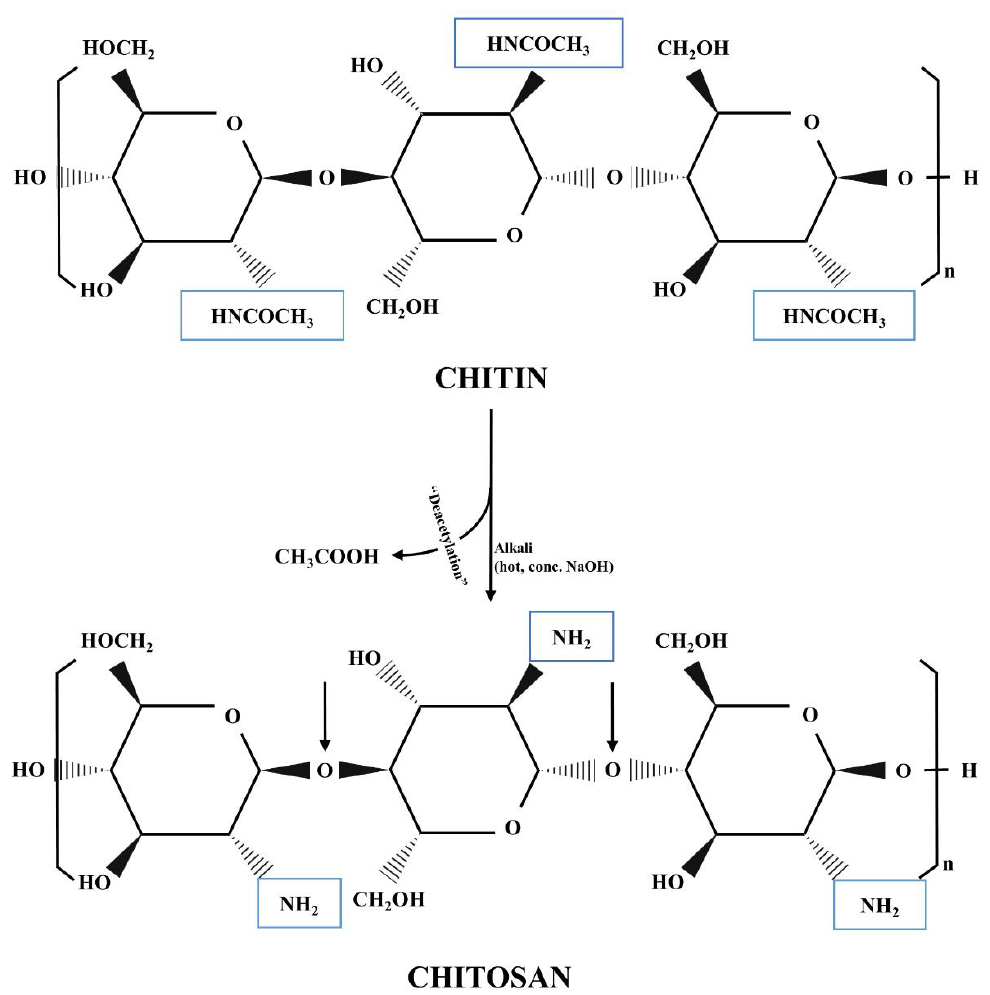
Figure 2. Chemical structure of chitin and chitosan, chitosan production from chitin.